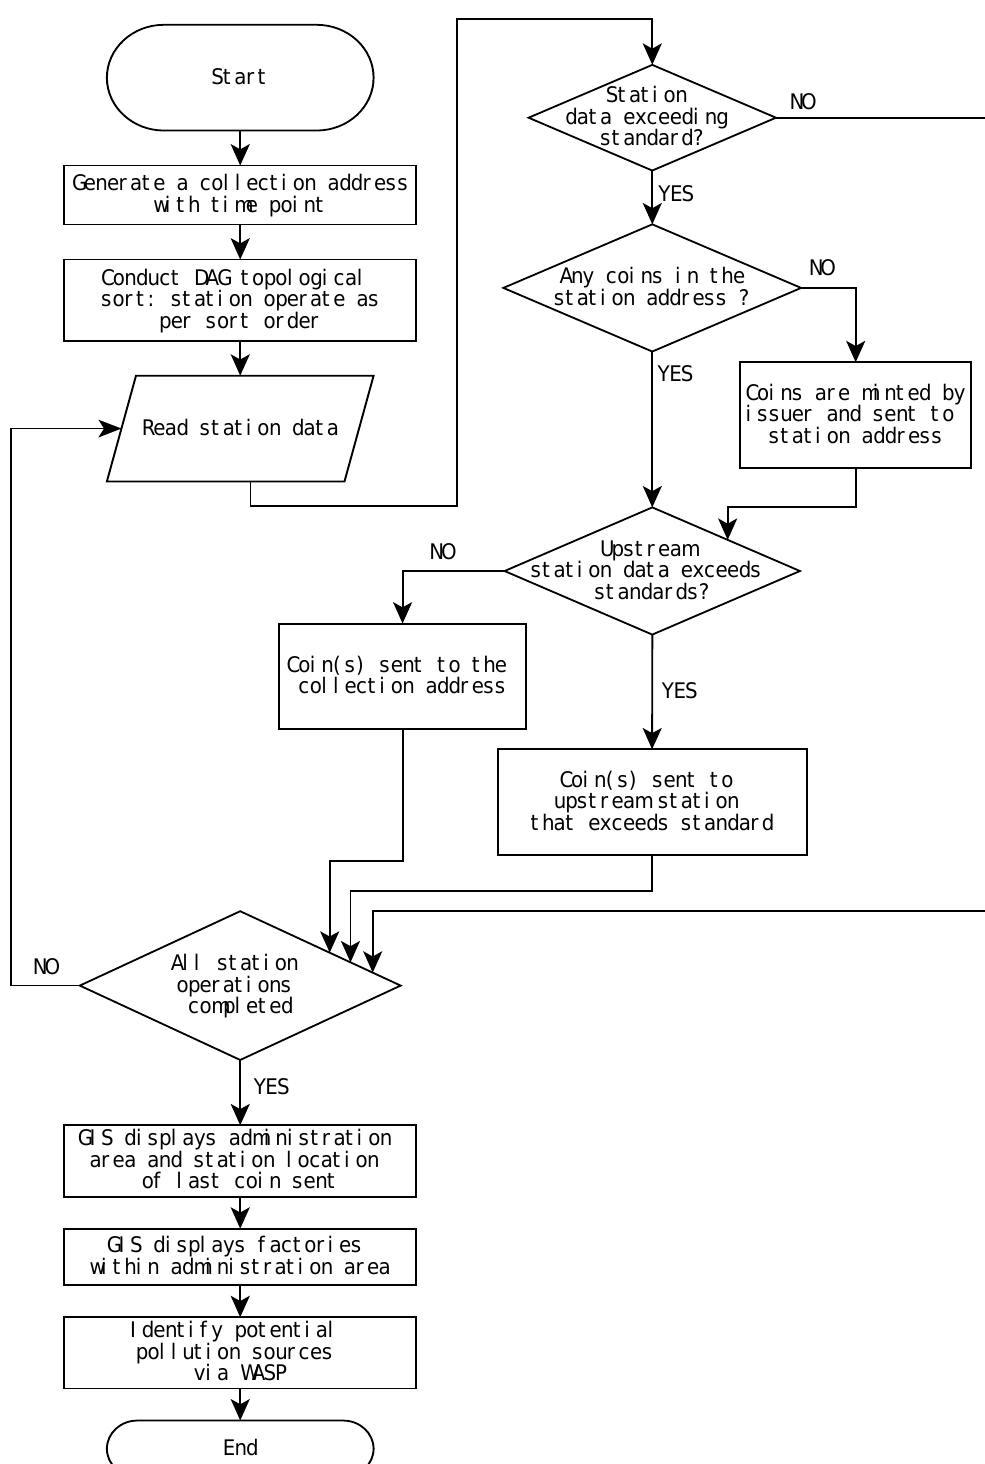
Figure 1. Flowchart of the data uploading process for the identification of pollution events and potential sources. Note: Directed Acyclic Graph (DAG); Geographic Information System (GIS); Water Quality Analysis Simulation System (WASP).